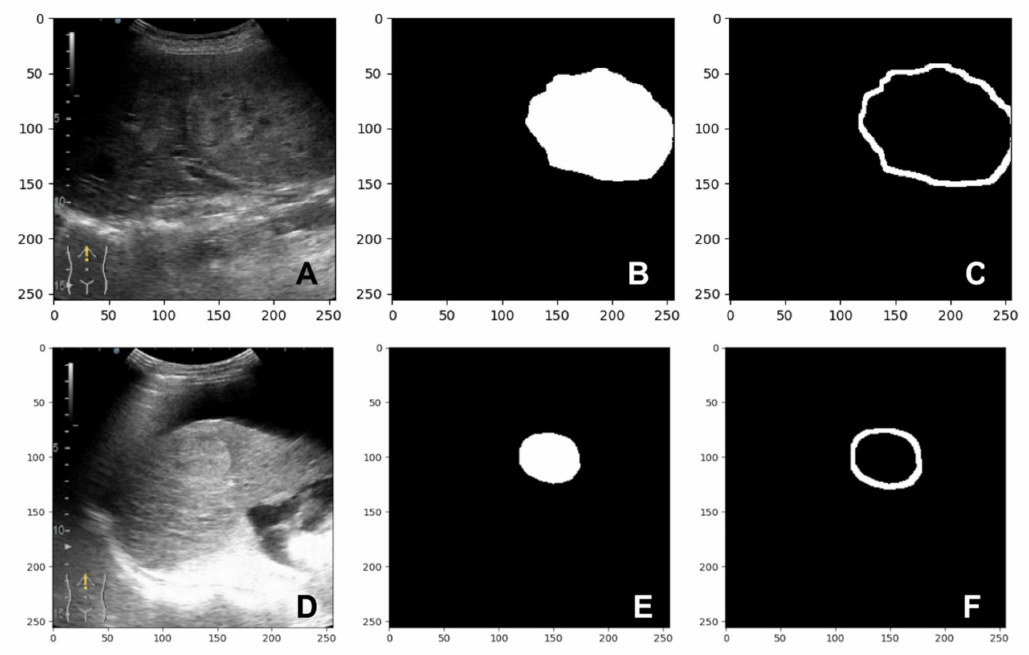
Figure 4. Sample frame from a patient with hepatocarcinoma: ( A , D ) B-mode frame; ( B , E ) predicted mask; ( C , F ) parenchyma